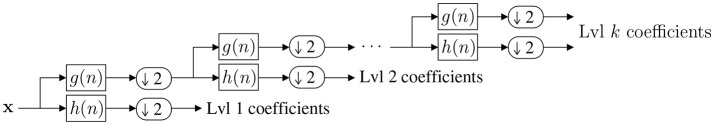
Computation of the discrete wavelet transform using consecutive filtering and down-sampling by two. Here h(n) denotes the high-pass filter and g(n) denotes the low-pass filter of the wavelet transform. Using this approach, the Haar transformation of a n×n image takes approximately (16/3)n2 MACs, as a single level of the transform takes 4n2 MACs and as the Wavelet transform is applied recursively to the upper left corner of the transformed image.